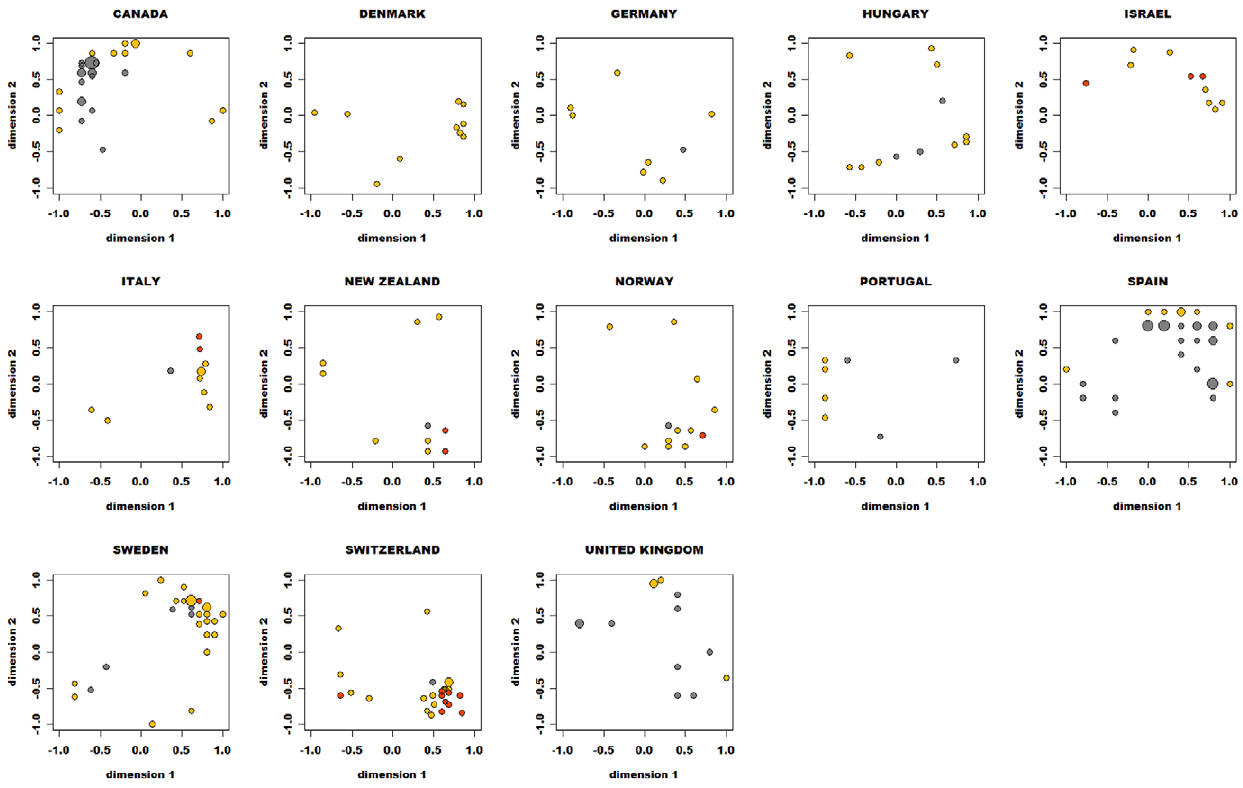
Figure 4. Scatterplots of the Kendall’s correlation coefficient of each expert between the MDS dimensions and the left–right ideology scale in the survey. Orange color indicates statistical significance (p , .05) of one (of two) dimension, and red color indicates statistical significance (p , .05) of both dimensions.